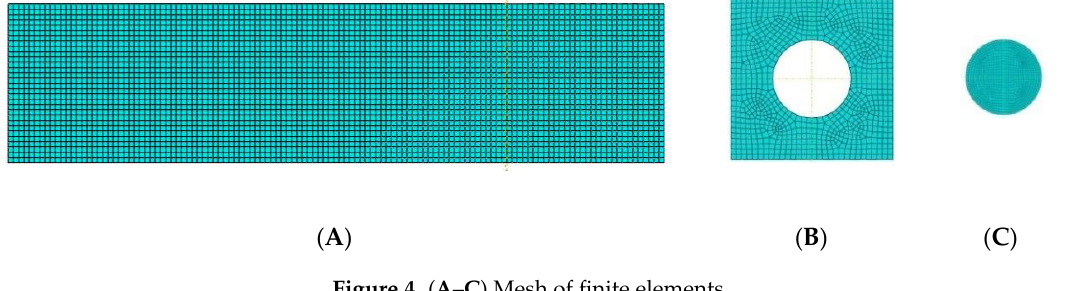
Figure 4. ( A – C ) Mesh of finite elements.